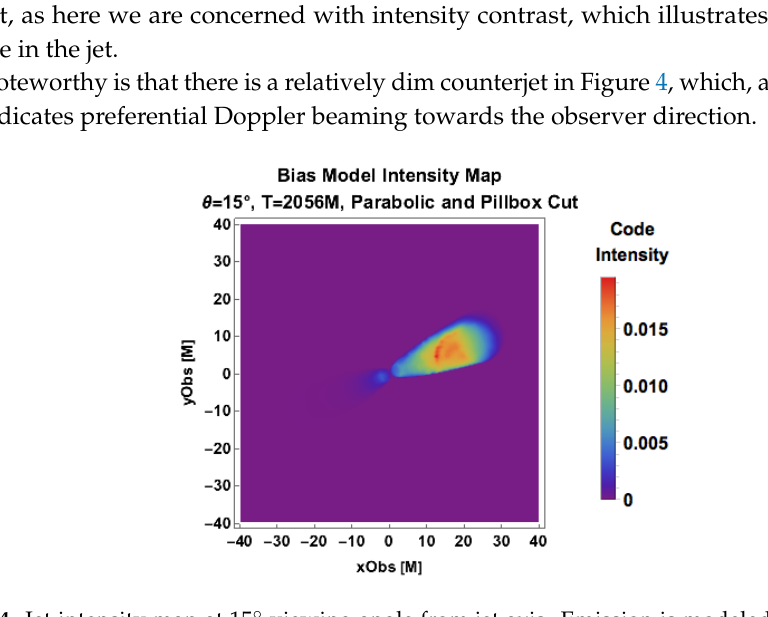
Figure 4. Jet intensity map at 15 ◦ viewing angle from jet axis. Emission is modeled as j ∼ ( b µ b µ ) 3 4 ( N = 0 bias model). Using a parabolic region to subtract the disk, all regions away from the locus satisfying 0.5 | z | > x 2 + y 2 > 20 are set to zero. A counterpropagating jet is also visible.